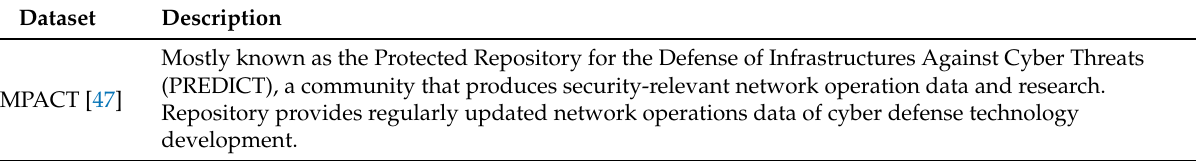
Table 2. Summary of cybersecurity